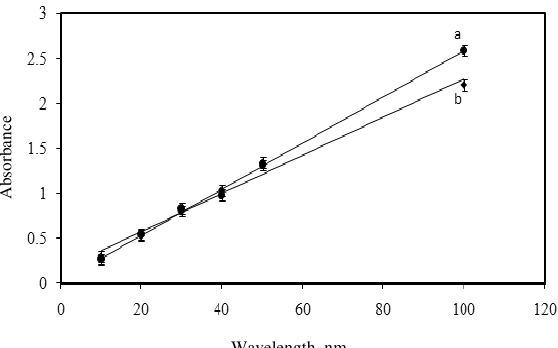
Figure 5. Calibration curves for MTX in the absence (a) and presence (b) of DNA at 298 nm. Conditions: phosphate buffer (0.1 mol L -1 , pH 7.4) plus NaCl (0.1 mol L -1 ), C =138.2 µ mol L -1 DNA